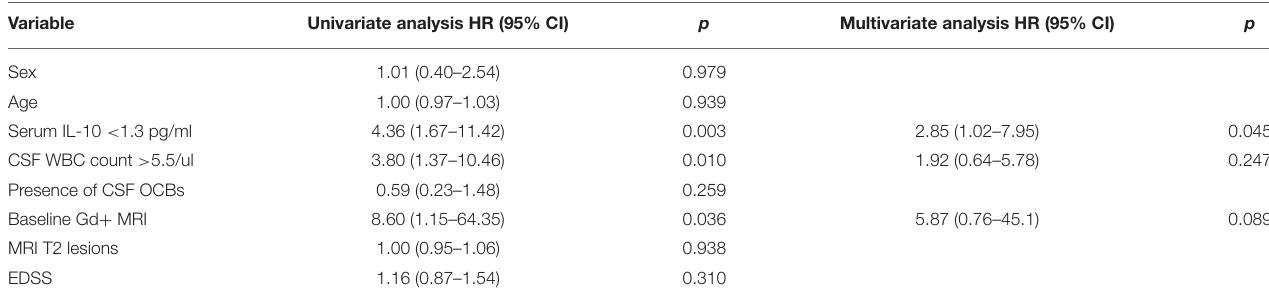
TABLE 2 | Cox regression models containing univariate and multivariate analyses of factors related to the time to relapse.